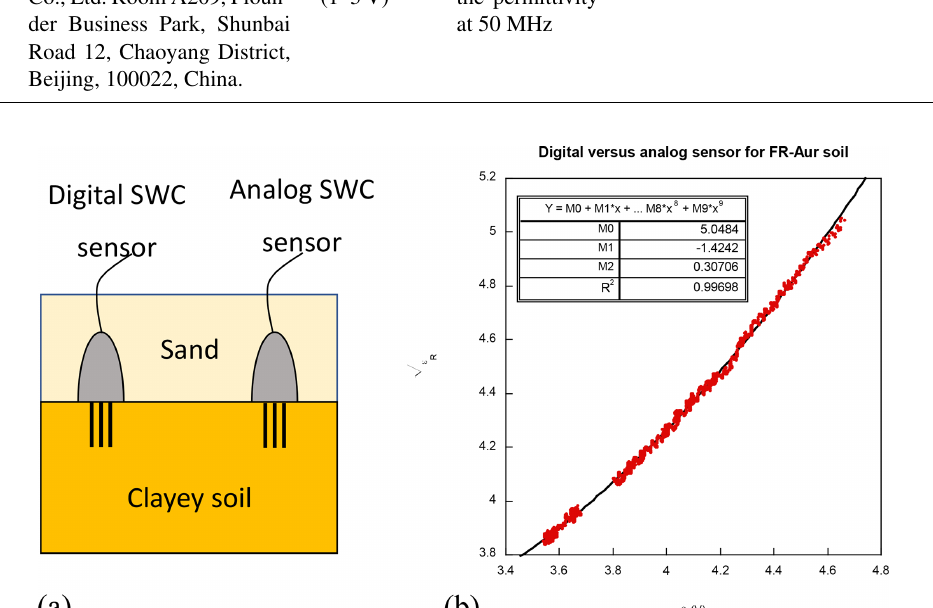
We used the determination coefficient ( R 2 , Eq. 5.) to com- pare the respective accuracies of calibration